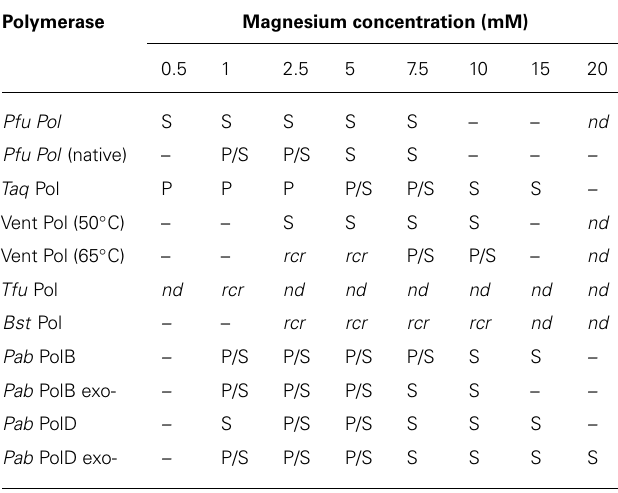
The main product obtained for each reaction is shown. S indicates slipped molecules, generated by replication slippage error. P indicates parental molecules, indicative of faithful replication. rcr indicates high molecular weight molecules generated by rolling circle replication as a consequence of the strand displacement activity of a DNA polymerase. nd, not